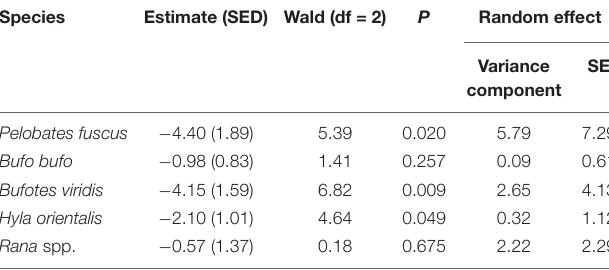
Estimates of habitat (categorical fixed factor) effect refer to fish-poor ponds (used as the reference level) and fish-dominated ponds, respectively. Average standard errors of differences are shown in